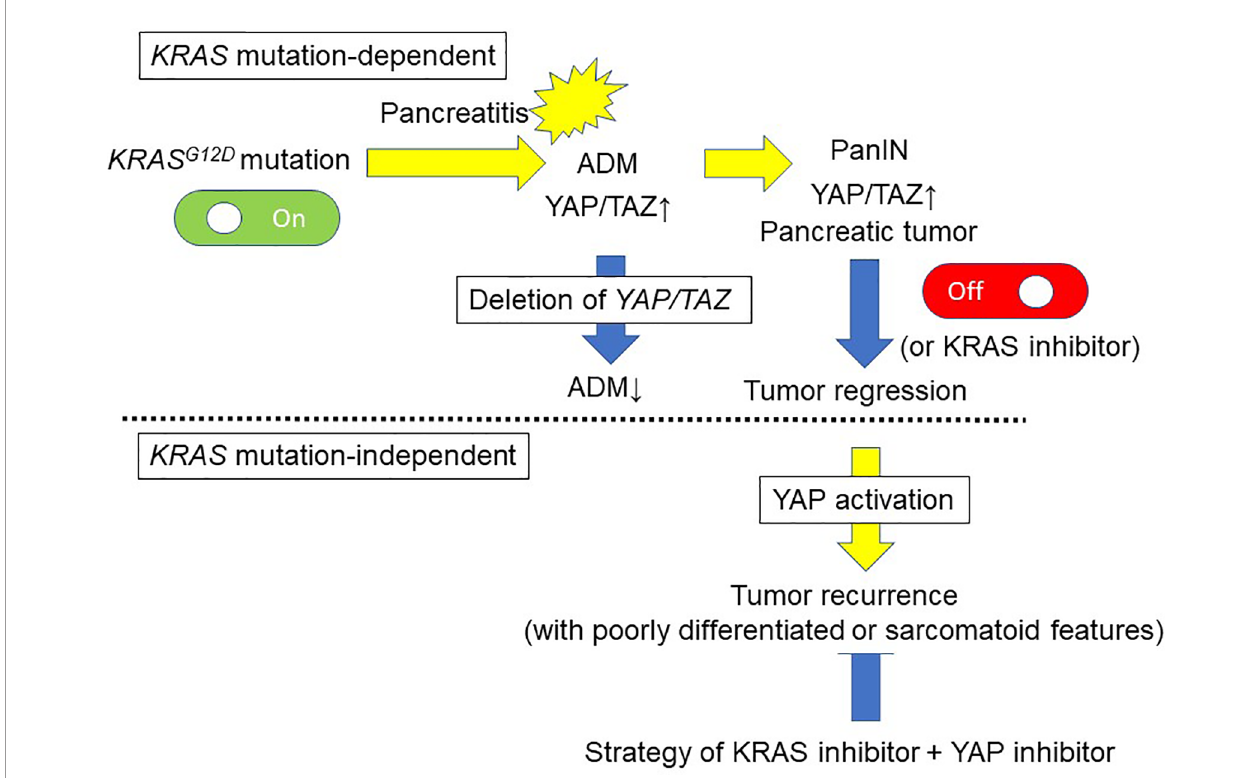
FIGURE 3 | Pancreatictumor development and maintenance byKRAS-dependent and KRAS-independent mechanisms via YAP activation. Oncogenic KRAS mutationis a key event of the development of PanIN lesions. Acinar-to-ductalmetaplasia (ADM) caused by pancreatitis is an initiating step in pancreatic tumor development. The pancreatic tumor mouse model LSL-KRAS G12D ; Pdx1-Cre displays increasedADM lesions and development of PanIN in response to cerulein, accompanied byYAP/TAZexpression. On the other hand, deletionof YAP/TAZ reduces the ability of KRAS G12D mutant mice to developADM inresponse to cerulein, andthese mice are free ofPanIN lesions evenafter cerulein-induced pancreatitis. Inactivationof KRAS G12D inestablished tumor lesions can leadto tumor regression. Although KRAS G12D extinctioninduces regression of pancreatictumors, 70% of the mice develop relapsed tumors via oncogenic KRAS -independent mechanisms involving the YAP1 oncogene. Ananti-YAP1 therapeuticstrategy withKRAS-targeting agents may be requiredfor elective